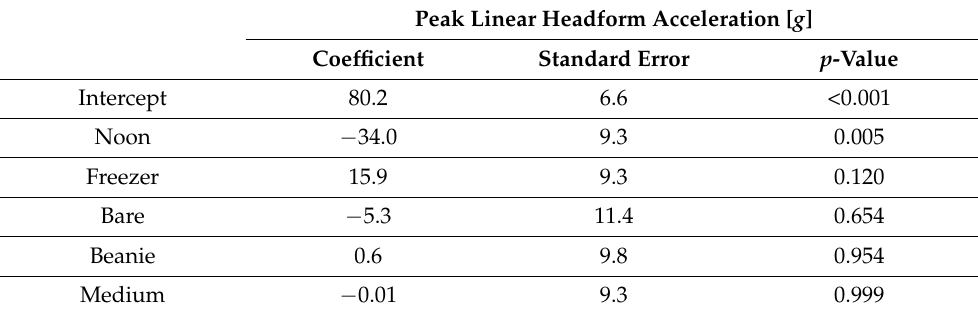
Table 2. Multiple linear regression of peak linear headform accelerations for vertical drop